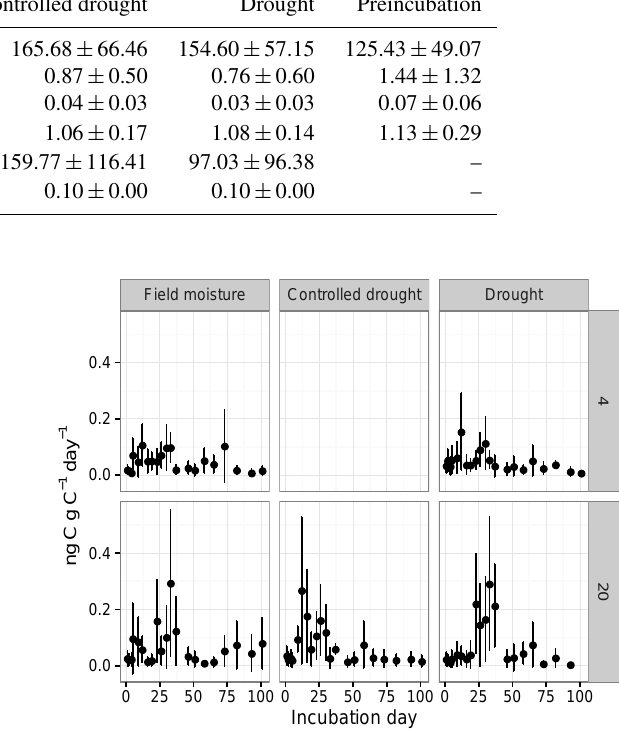
Figure 2. Mass-normalized CO 2 fluxes over the 100-day incubation by temperature (4 and 20 ◦ C, rows) and treatment (field moisture, drought, and controlled drought; columns). Error bars show core-to- core standard deviation. The controlled drought treatment, for 20 ◦ C only, was meant to dry cores at roughly the same rate as the drought cores at 4 ◦ C.